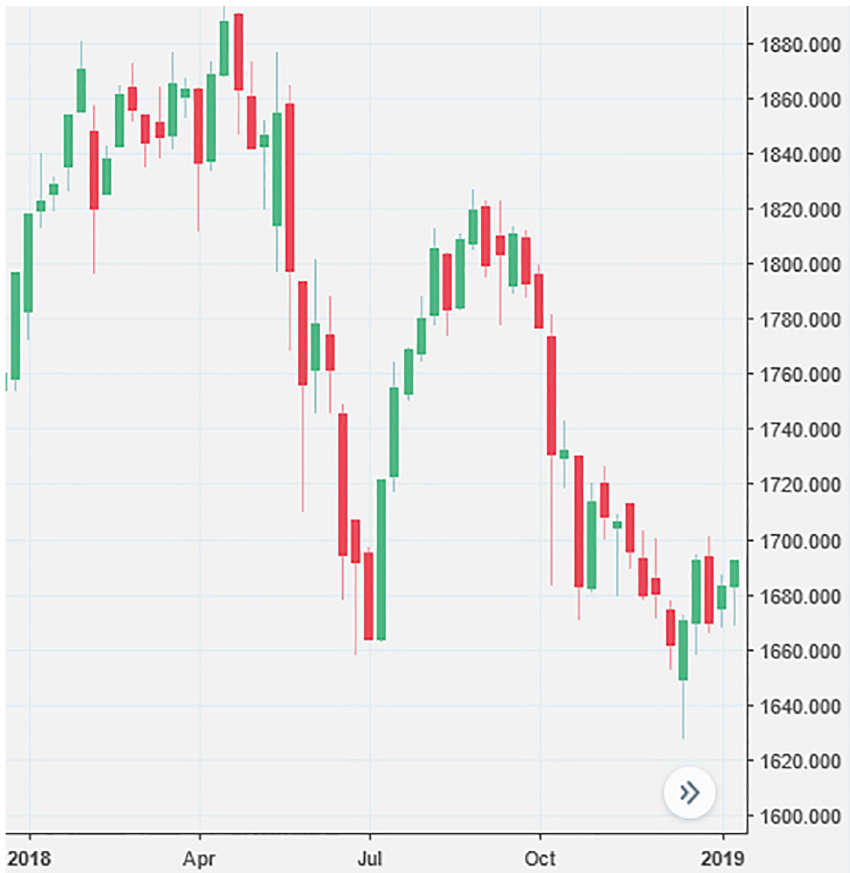
Figure 1. Bursa Malaysia KLCI Index lost more than 100 points in the year